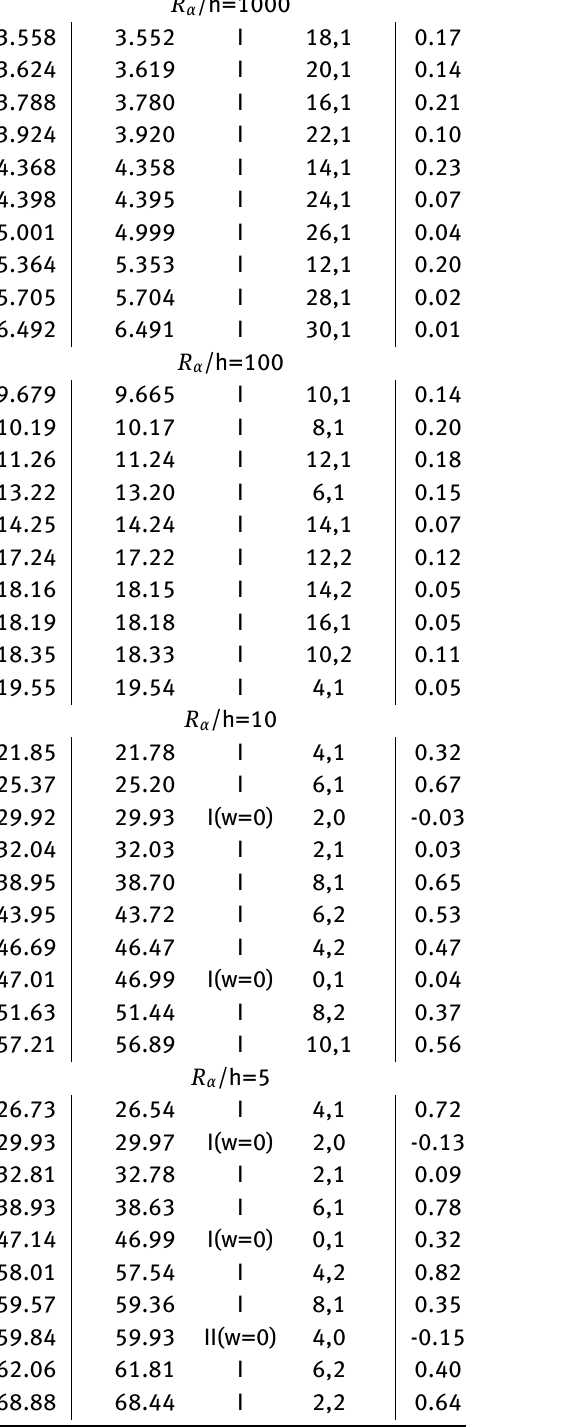
Table 18: Eleventh benchmark, simply supported sandwich plate embedding isotropic skins and PVC core with thickness